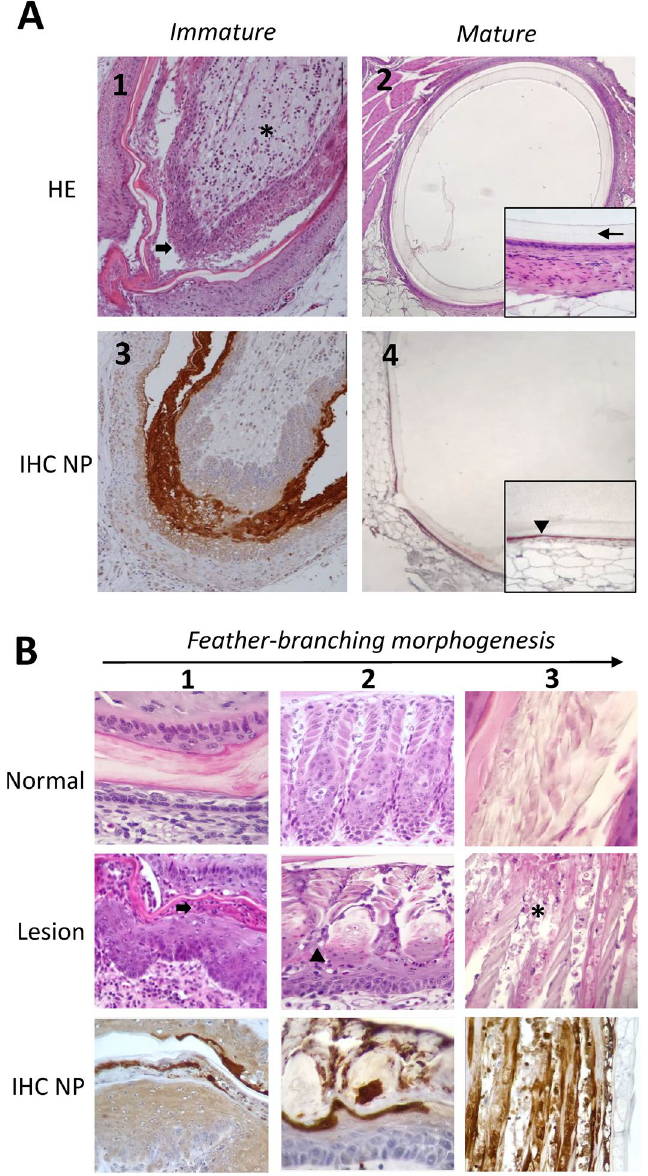
Figure 1. Lesion and viral detection in immature and mature feathers of naturally H5N8-infected ducks and geese. Hematoxylin and Eosin (HE) and anti-nucleoprotein A Immunohistochemistry (IHC). ( A ) Lesion and viral detection in immature and mature feathers, duck infected with H5N8 clade 2.3.4.4b, HE. ( A1 ) Immature feather with extensive acute necrosis of feather and follicular epidermis (arrow). The feather pulp is infiltrated by leukocytes, mainly lymphocytes and plasma cells (asterisk). ( A2 ) Mature feather with calamus (thin arrow) within normal limits. ( A3 ) Abundant viral antigen is present within necrotic debris and outer layers of feather and follicular epidermis. ( A4 ) Viral antigen is present in association with follicular epidermis of mature feather, under the calamus (arrowhead). ( B ) Growing and differentiating feather epidermis, duck infected with H5N8 clade 2.3.4.4b. ( B1 ) At early stage of differentiation, feather epidermis is stratified. Necrosis is visible at the outer (corneal) layer (arrow) with viral antigen colocalization. ( B2 ) At the stage of early differentiation, necrosis and single-cell necrosis/apoptosis can be seen within marginal plates and barb ridges (arrowhead) and with viral antigen colocalization. ( B3 ) At the stage of cornication, keratinized barbs and barbules are disrupted and intermixed with necrotic cells and debris (asterisk) with viral antigen